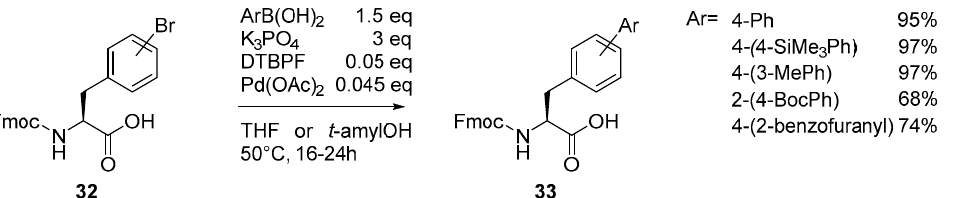
Figure 7. Synthesis of Fmoc-protected biphenylalanines 30 Figure 6. Synthesis of Fmoc-protected biphenylalanines 30. Figure 6. Synthesis of Fmoc-protected biphenylalanines 30.